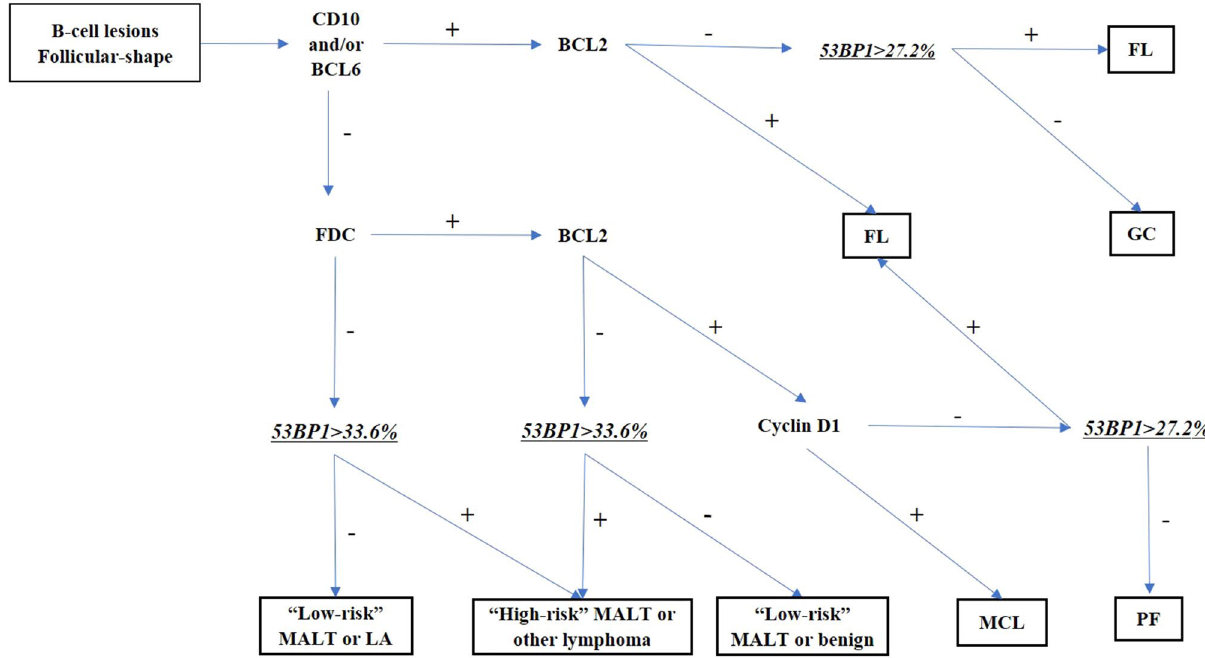
Figure 7. Proposed flow chart to diagnose follicular-shape B-cell lymphoid lesions in biopsy samples from the digestive tract by a combination of usual immunohistochemistry and immunofluorescence of 53BP1. GC germinal center, PF primary follicle, LA simple lymphoid accumulation, FL follicular lymphoma, MCL mantle cell lymphoma, MALT mucosa-associated lymphoid tissue lymphoma. “High-risk” MALT: showing t(11;18) (q21;q21) and insensitivity to H. pylori eradication therapy. “Low-risk” MALT: showing no chromosomal translocation and sensitivity to H. pylori eradication